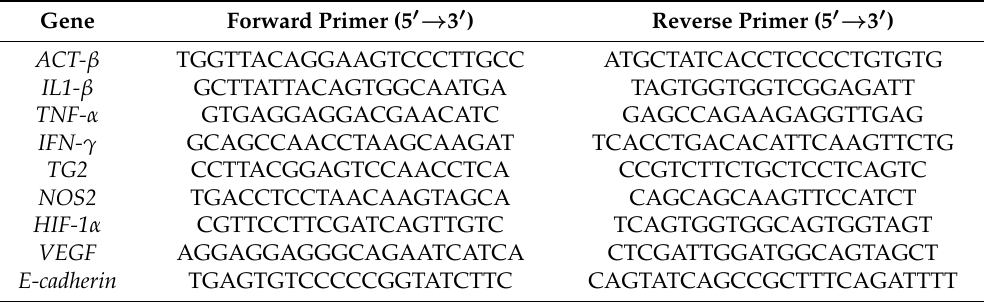
Table 1. qRT-PCR primer